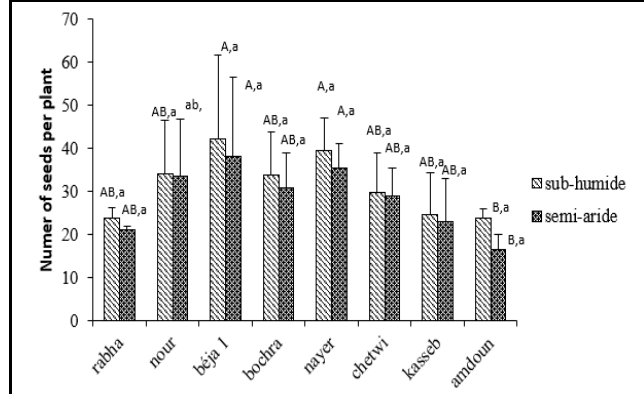
Figure 5: Mean values of number of seeds per plant as a function of the